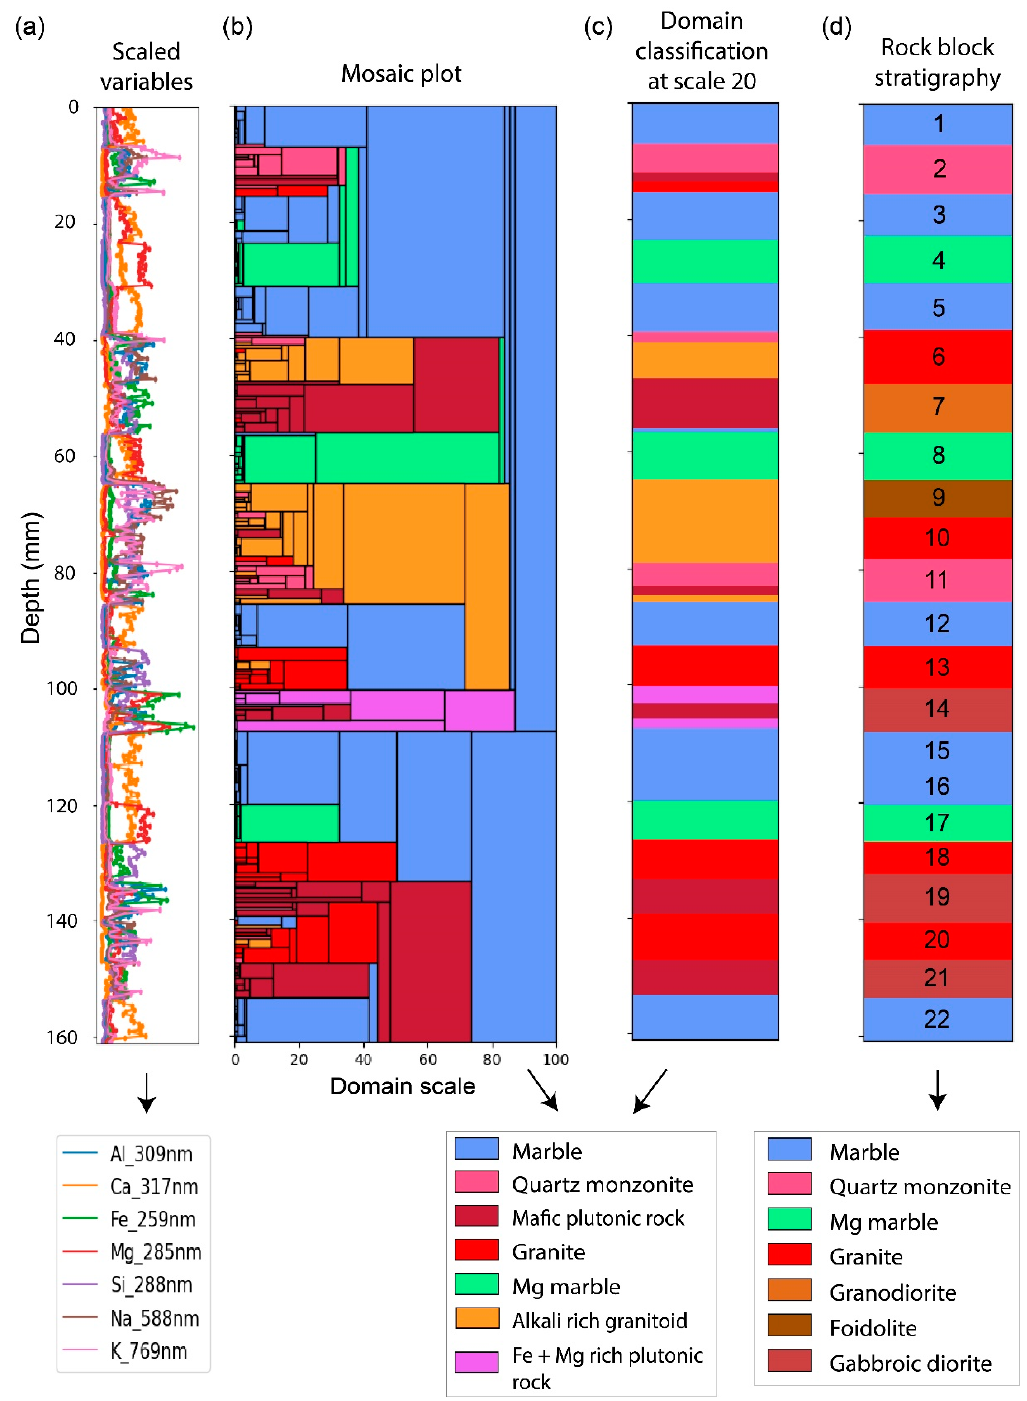
Figure 7. Results for seven domain analysis of raw LIBS data based on classification by k -means clustering. ( a ) Scaled variables; ( b ) multiscale mosaic plot for seven domains produced by wavelet tessellation of raw LIBS data block stratigraphy with rock slab numbers; ( c ) domain classification pseudolog for seven domain classification at domain scale 20; ( d ) Rock block stratigraphy with rock slab numbers.